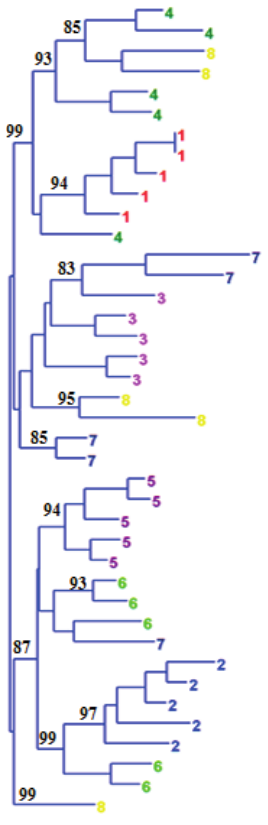
Figure 1. NJ tree of populations in Pistacia khinjuk based on IRAP data. Bootstrap value from1000 replicates are indicated above branches (Population numbers are according to Table